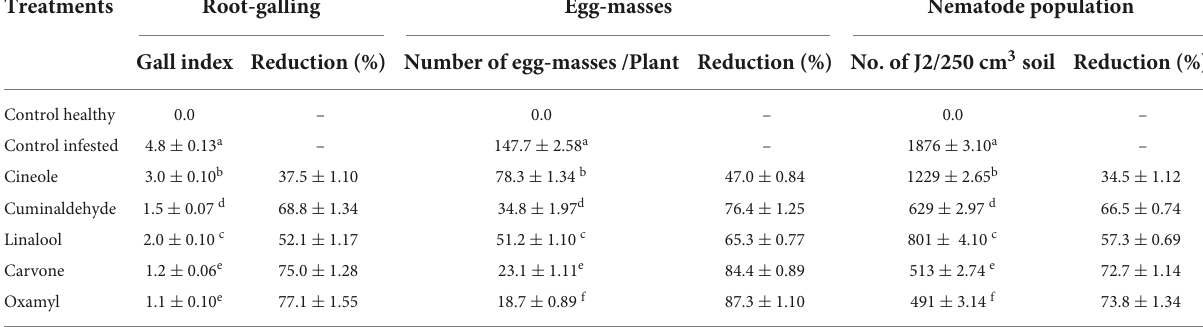
TABLE 5 Effect of treatments on root galling, egg masses, and juveniles in tomato plants under greenhouse conditions. Treatments Root-galling Egg-masses Nematode